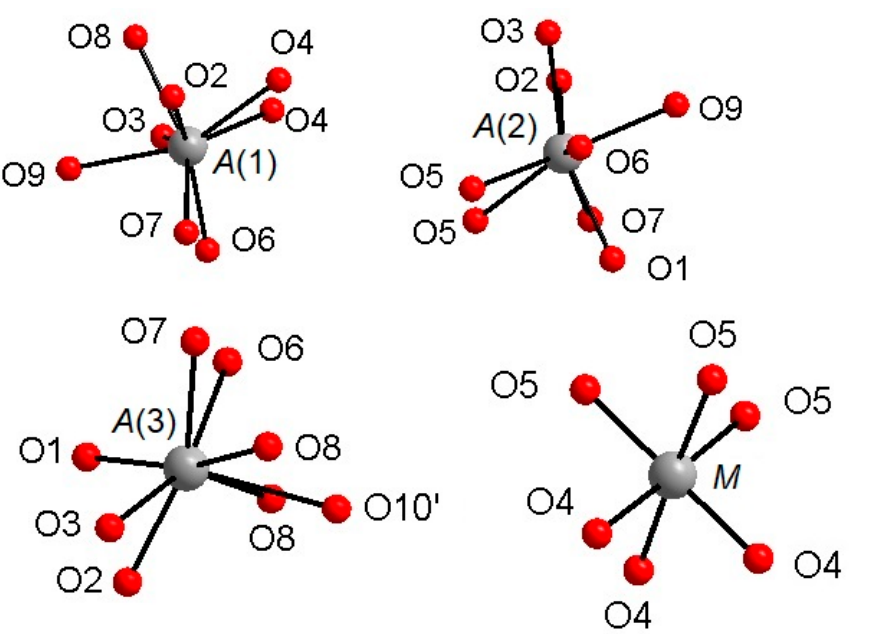
Figure 2. Coordination environments around the A (1)– A (3) and M cationic sites.